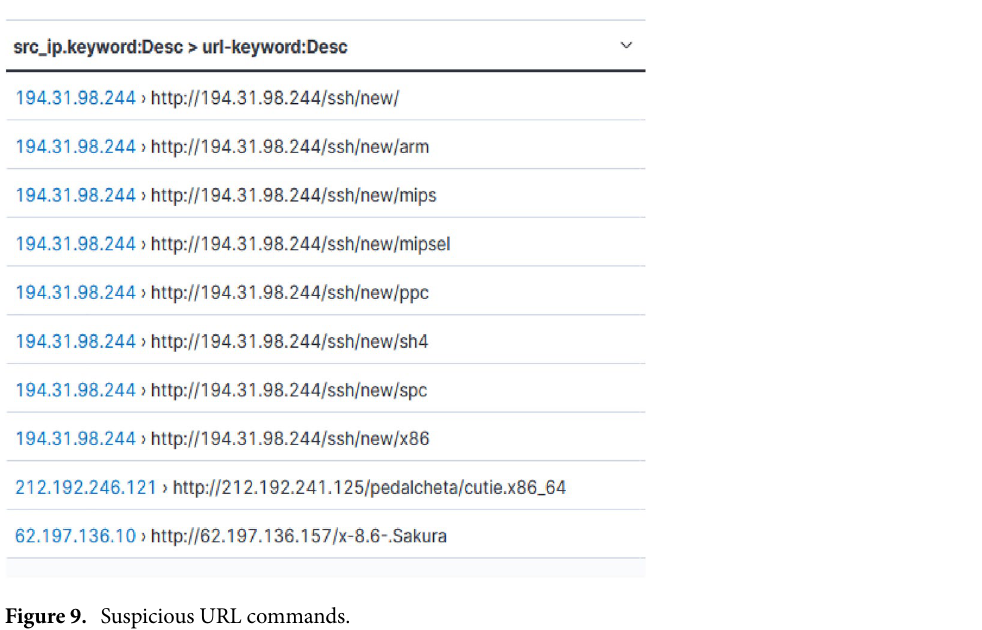
Figure 9. Suspicious URL